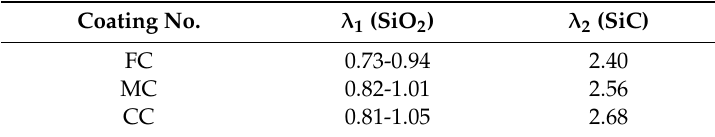
Table 4. The ratios ( λ ) between the hardness of the abrasive ( H a ) and the WC-20Cr 3 C 2 -7Ni coatings ( H m